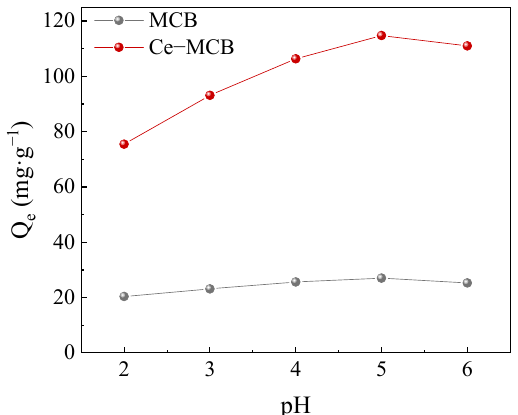
Figure 10. Effect of initial solution pH on Pb 2+ removal by MCB and Ce-MCB.